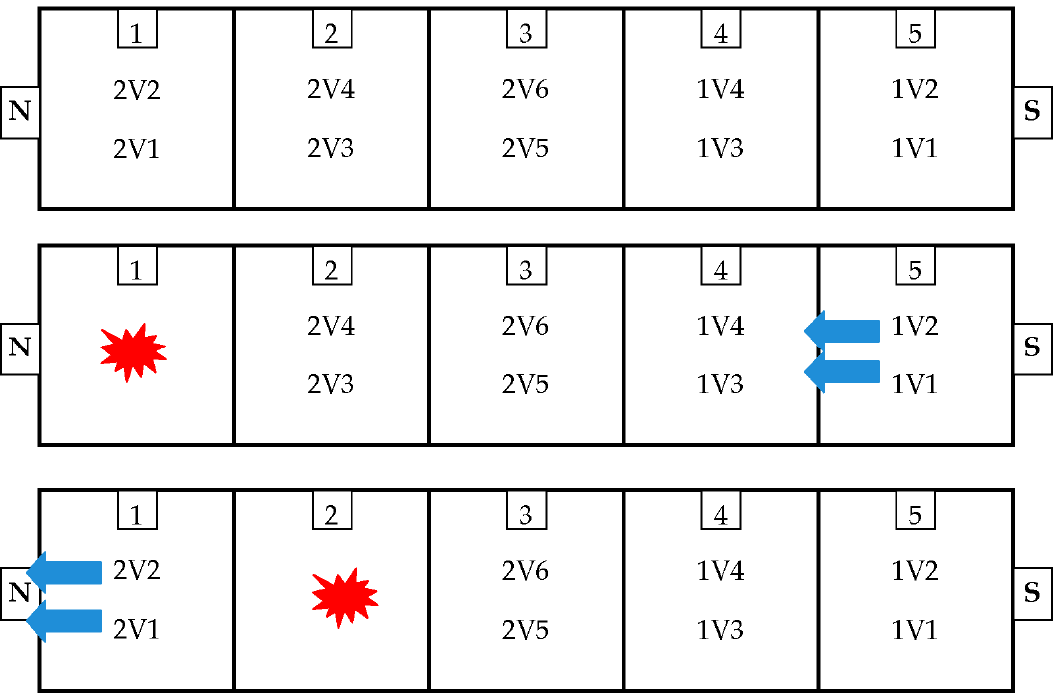
Figure 2. Zones in the tunnel. Dimensions are given in meters; the figure is not in scale. Red spot denotes fire localization, blue arrows denote working fans and flow direction.